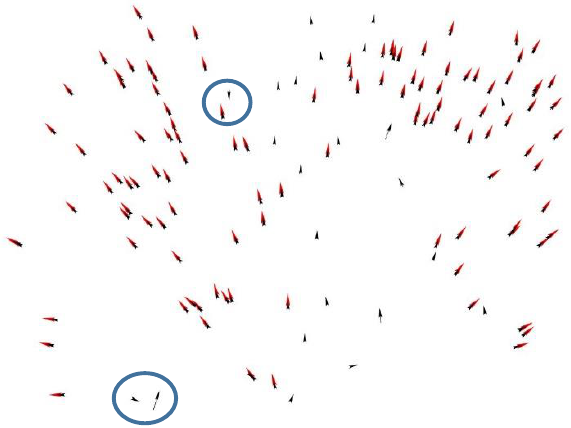
Figure 3. Vectors depicting the spatial matching of the homological points: before filtering (black), and after filtering (red); homological points that are filtered (blue